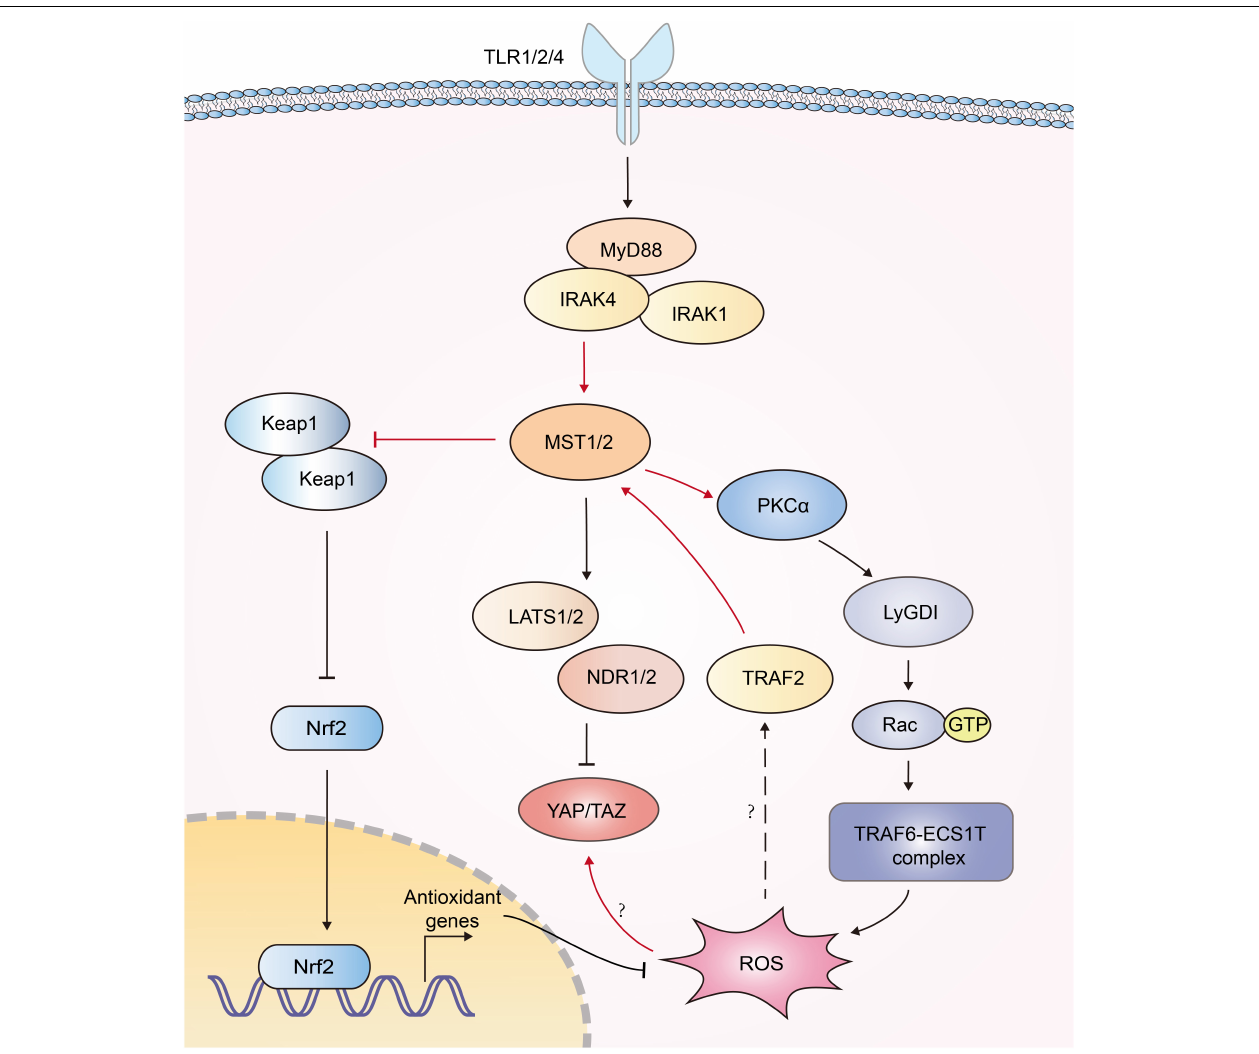
FIGURE 5 | Interplays between Hippo signaling and ROS production. Recognition of bacterial infections by TLR1/2/4 triggers activation of MST1/2. Then MST1/2 phosphorylates PKC- α and activates PKC α -LyGDI-Rac cascade to induce assembly of the TRAF6-ECSIT complex, which is required for recruitment of mitochondria to phagosomes and ample ROS production. MST1 is activated by TRAF2 in response to H 2 O 2 stimulation via unknown mechanism. MST1/2 phosphorylates Keap1 and prevents Keap1-mediated Nrf2 degradation, resulting in the expression of antioxidant genes. High intracellular ROS increase YAP expression independent of